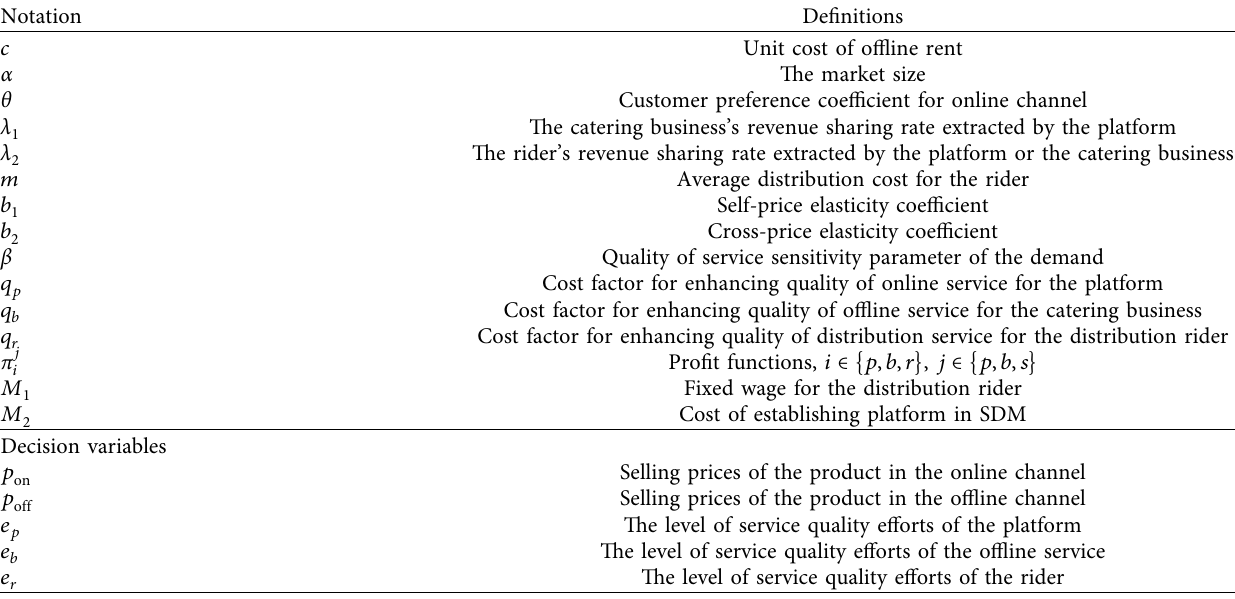
Table 1: Notation and